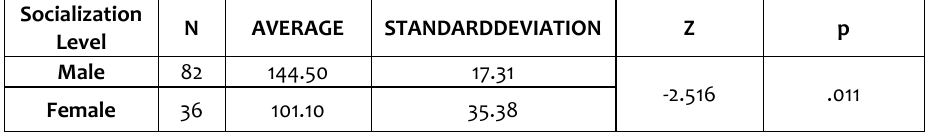
Table 4. Comparison of the Level of Socialization According to the Sexes of Obese Youth